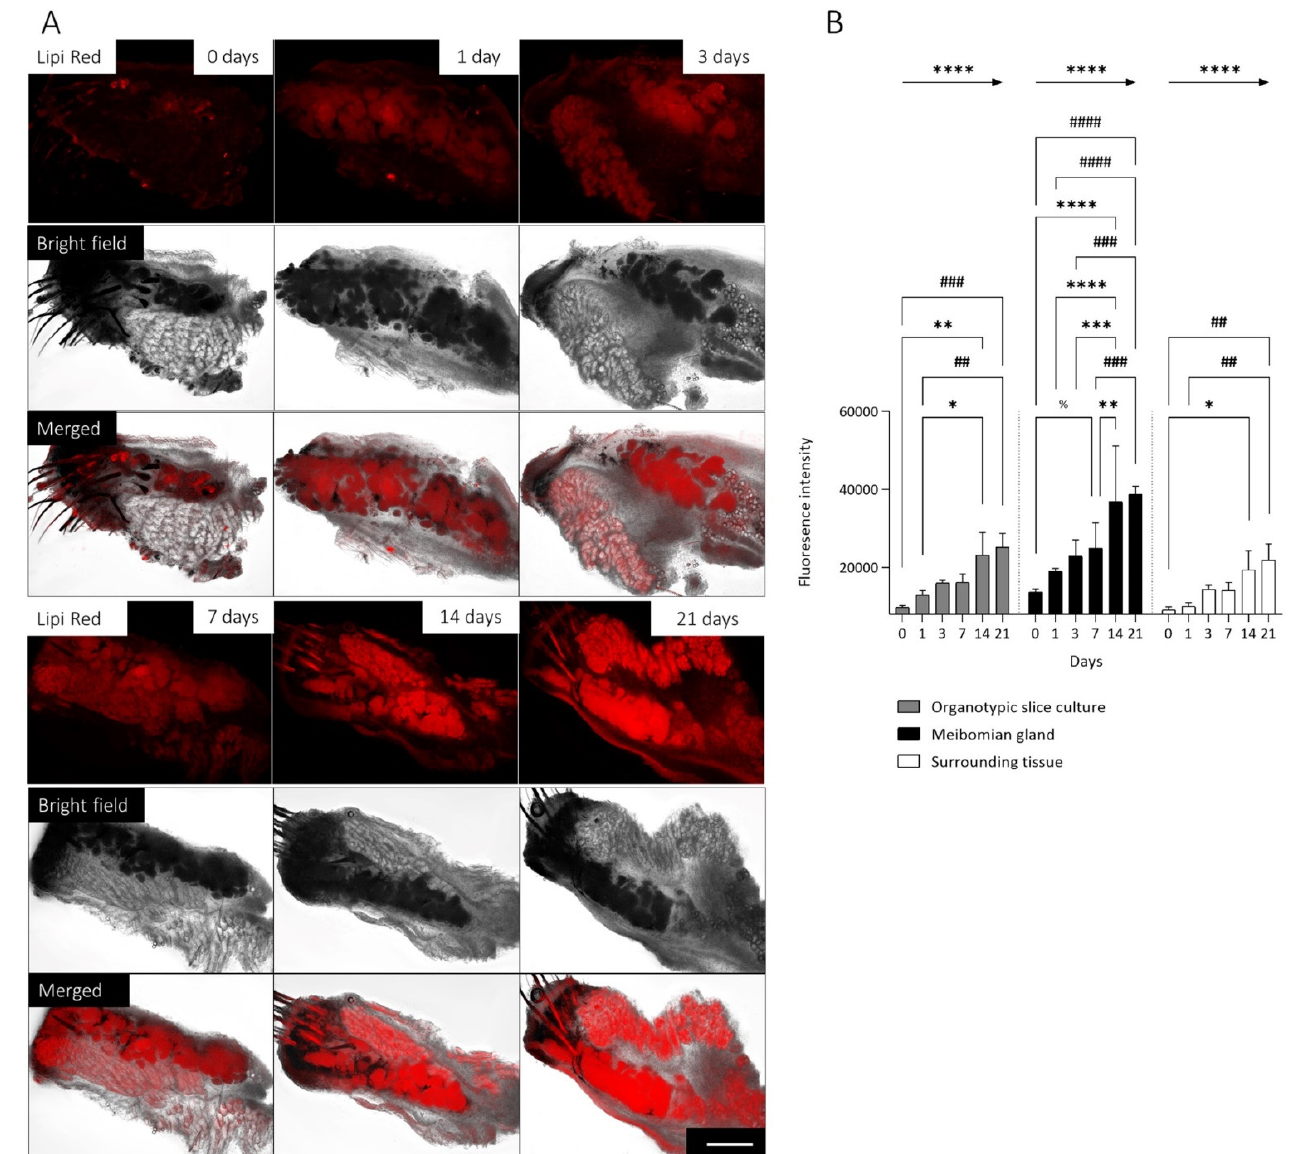
Figure 2. Lipid production in organotypic slice cultures (OSC) of mouse meibomian glands (mMG) over 21 days. Representative pictures of lipid droplets visualized by Lipi Red staining of mMG OSCs for 21 days. Bright field imaging shows the position of the mMGs within the OSC. Most lipid droplets are located in the mMGs ( A ). During the cultivation period, the fluorescence intensity increases significant linearly in the whole OSC, for the mMG as well as the surrounding tissue ( B ). Significant changes compared to day 7 are assigned as %/day 14 are assigned as */day 21 are assigned as #. Arrows indicate a linear trend test. Data are n = 4, mean ± SD, */% p ≤ 0.05, **/## p ≤ 0.01, ***/### p ≤ 0.001, ****/#### p ≤ 0.0001 ( B ). Scale bar: 200 µm ( A ).